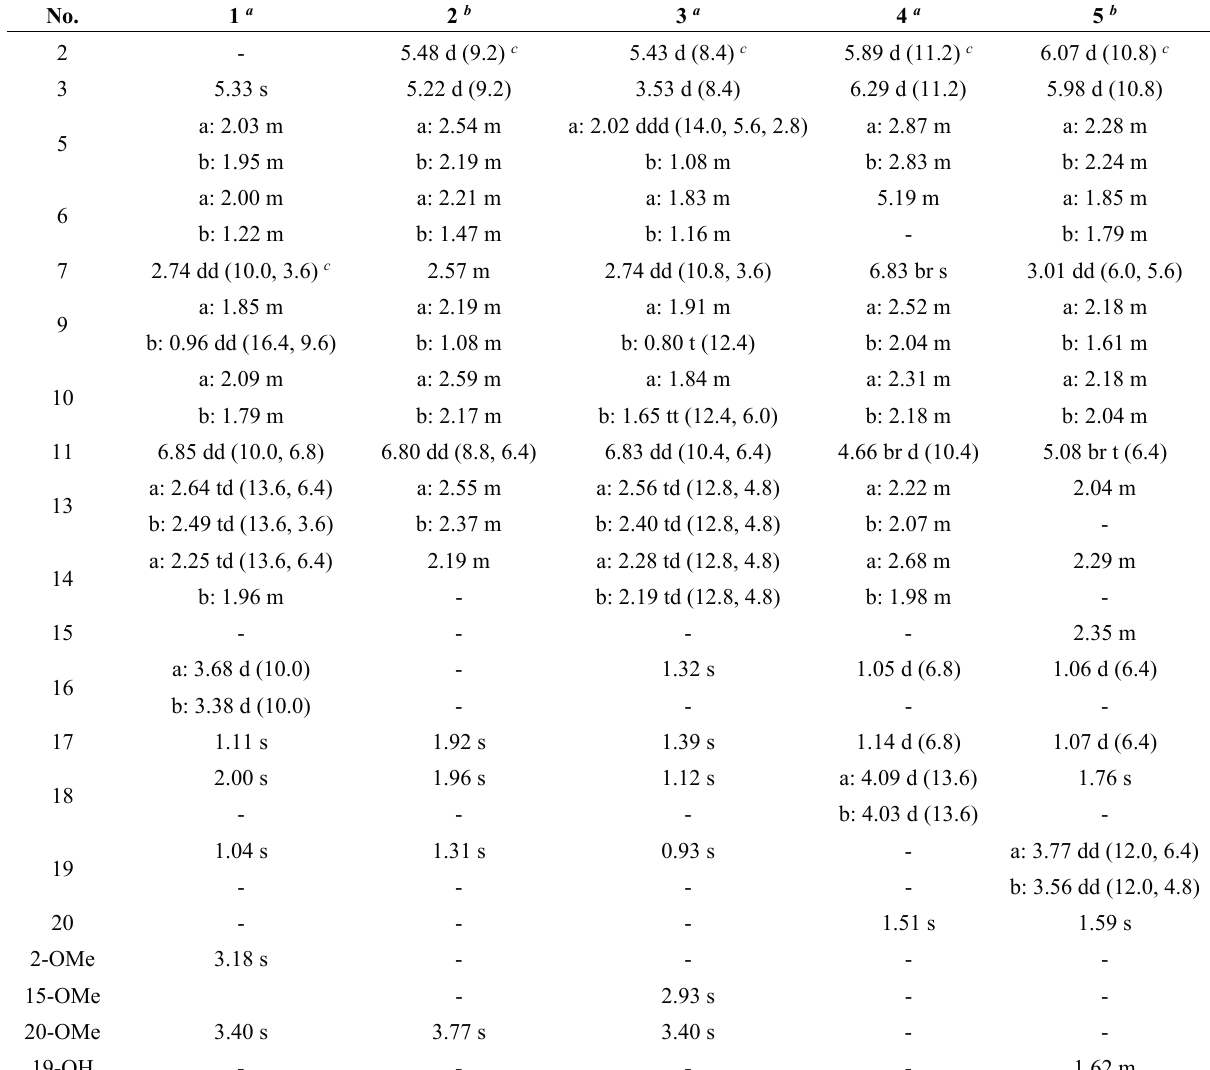
a Spectra were measured in C (in Hz) are in